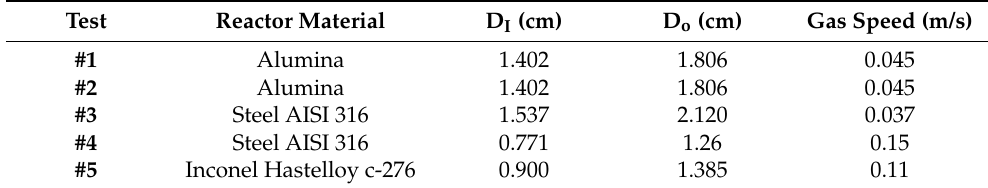
Table 2. Type of material used for the reactor, internal and external diameters of the pipes and gas speed.